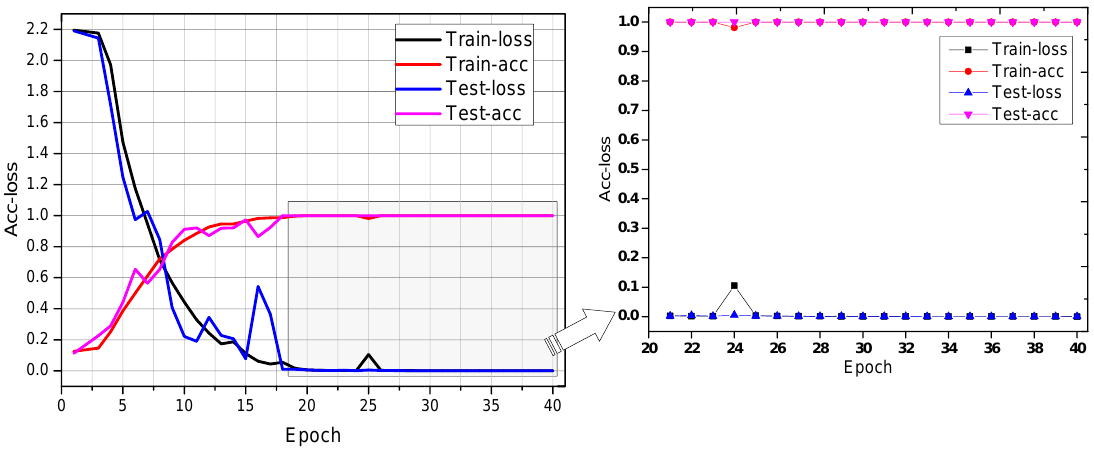
Figure 10. The iterative process of training and testing for 40 epochs.